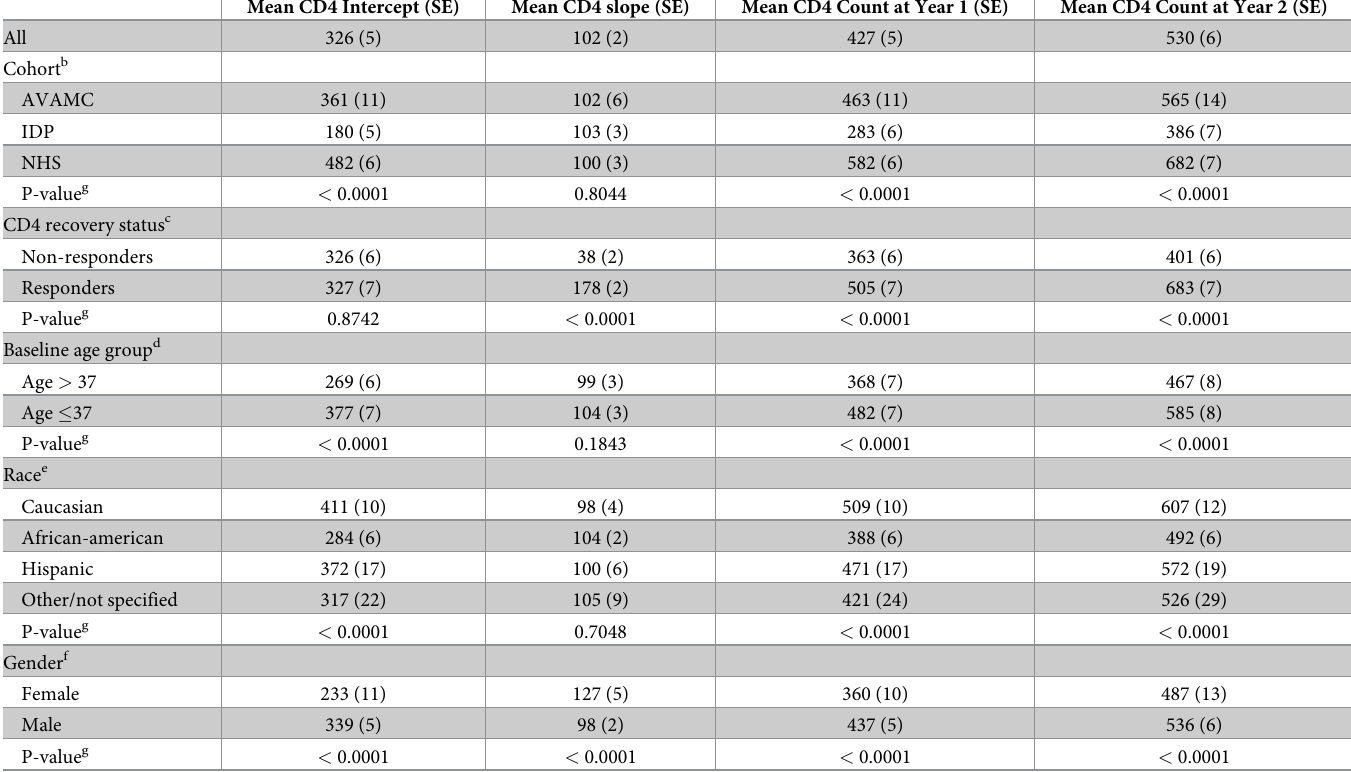
Table 2. Estimated a mean CD4 intercept (cell/ μ L), estimated mean CD4 count (cell/ μ L) after 1 and 2 years from ART initiation and the estimated mean CD4 slope (cell/ μ L/year) during the two years following ART initiation by cohort, CD4 recovery status and baseline age